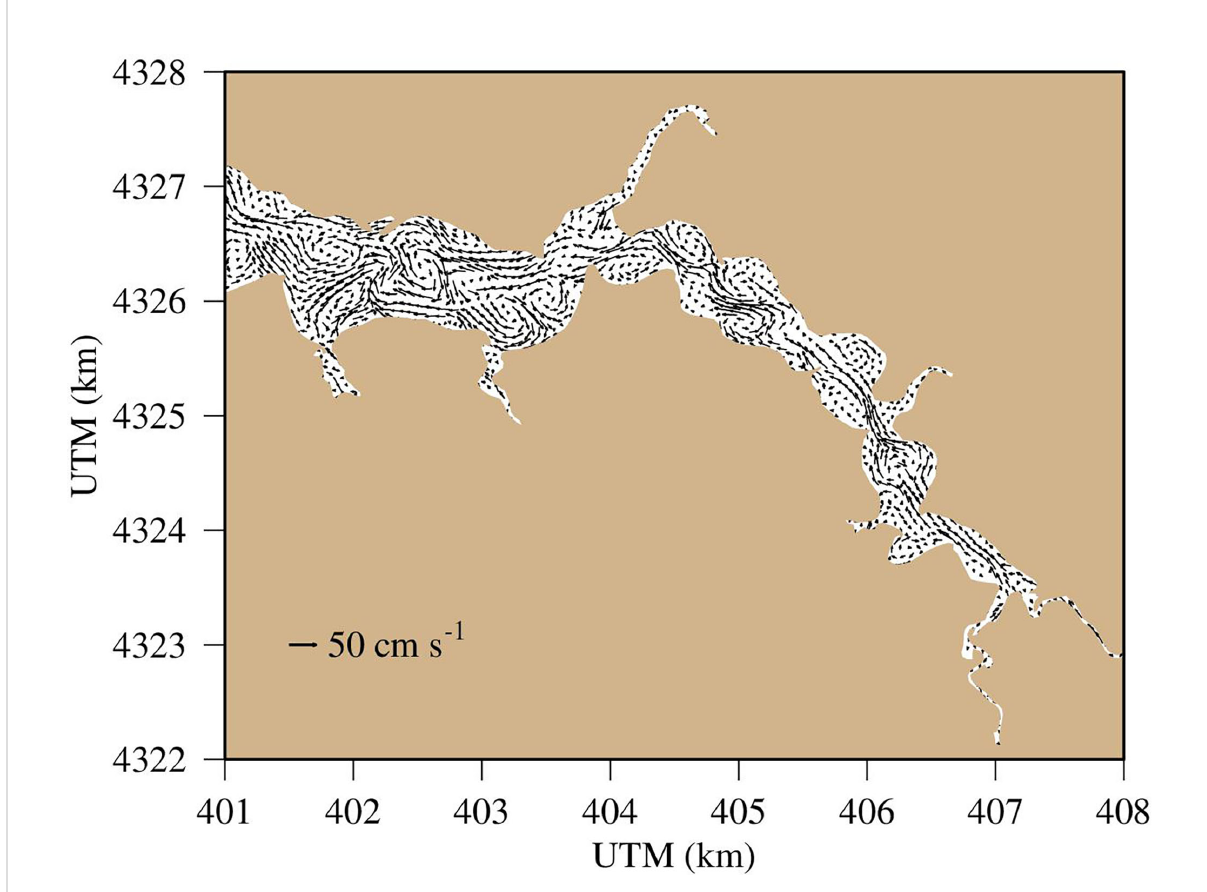
FIGURE 11 Simulated surface current on July 20,